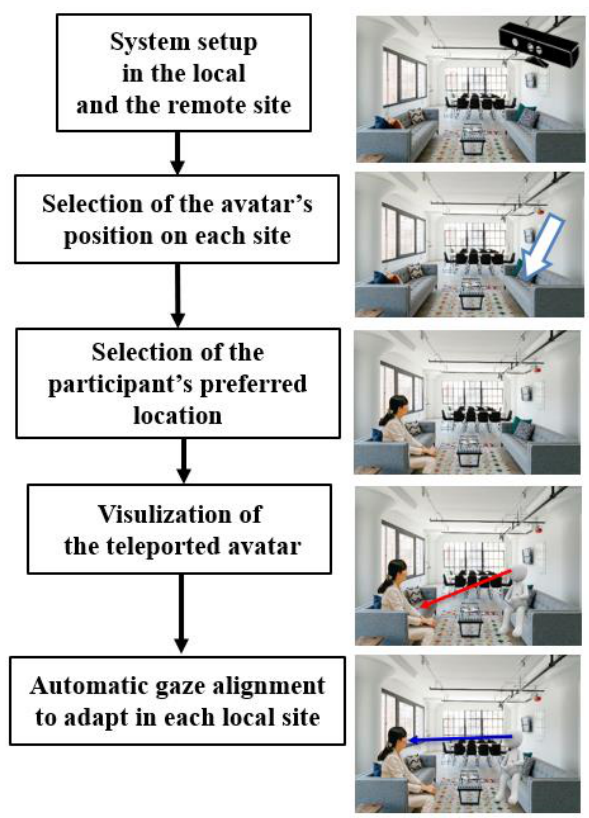
Figure 5. Automatic gaze alignment process of the teleported avatar.